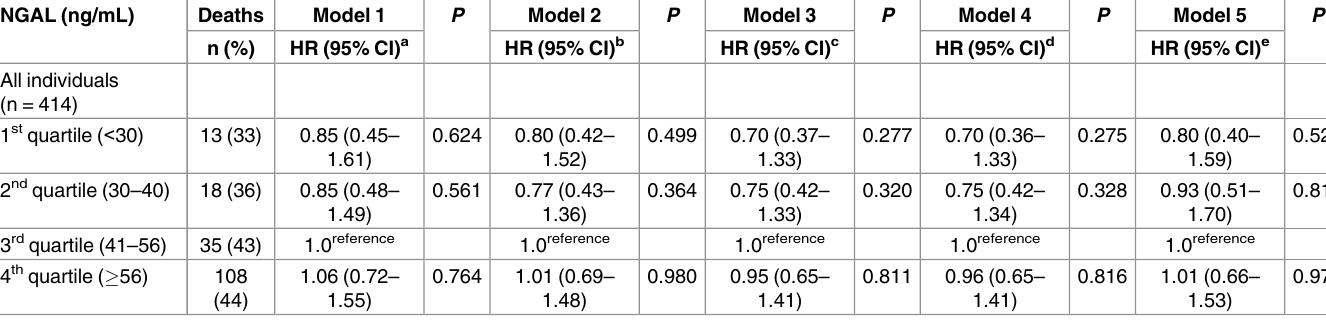
Table 8. Hazard ratios (HR) for death from cardiovascular causes according to NGAL (eGFR (cid:20) 60 ml/min/1.73 m 2 ). NGAL